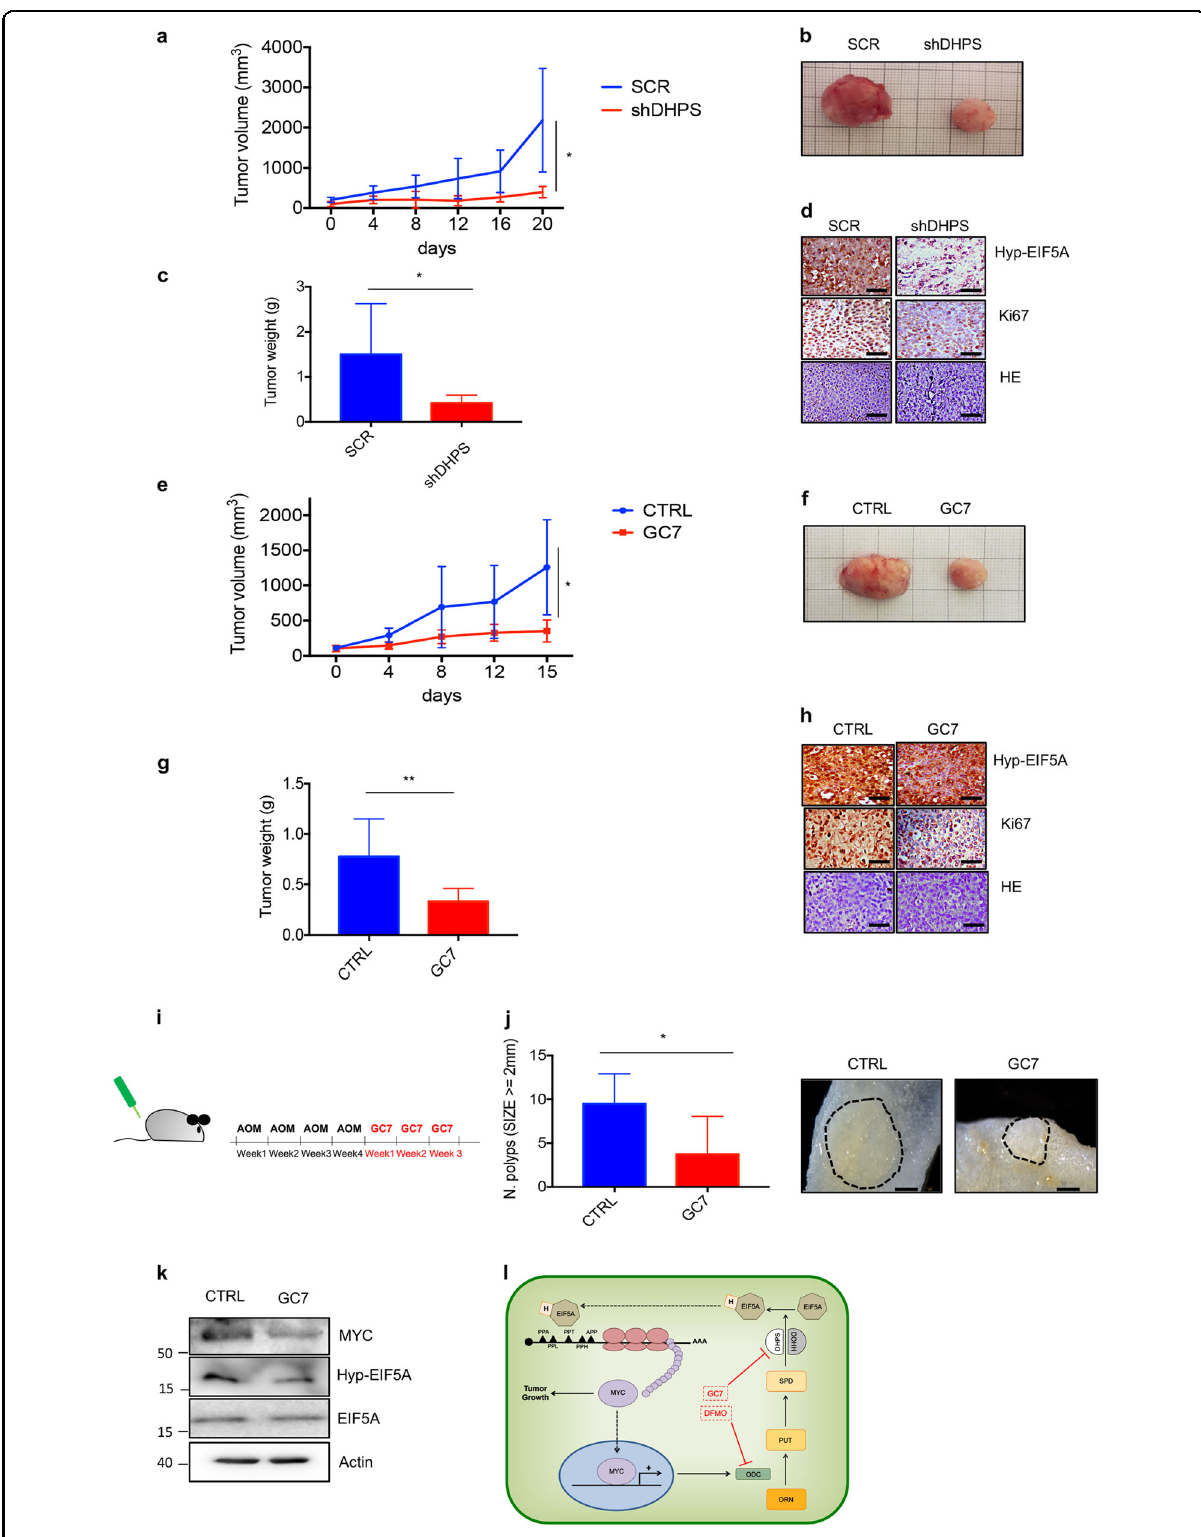
Fig. 5 (See legend on next